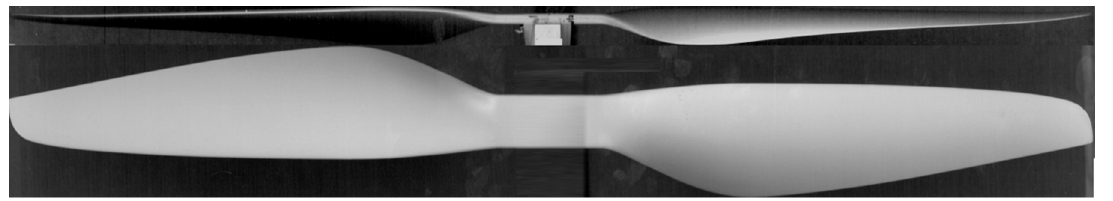
Figure 3. T-Motor 16 inch × 5.4 inch isometric top and side view images taken with a conventional scanner.